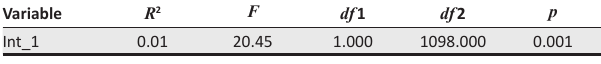
TABLE 5: Interactive effect between workplace bullying and emotional intelligence in predicting flourishing ( R 2 increase resulting from